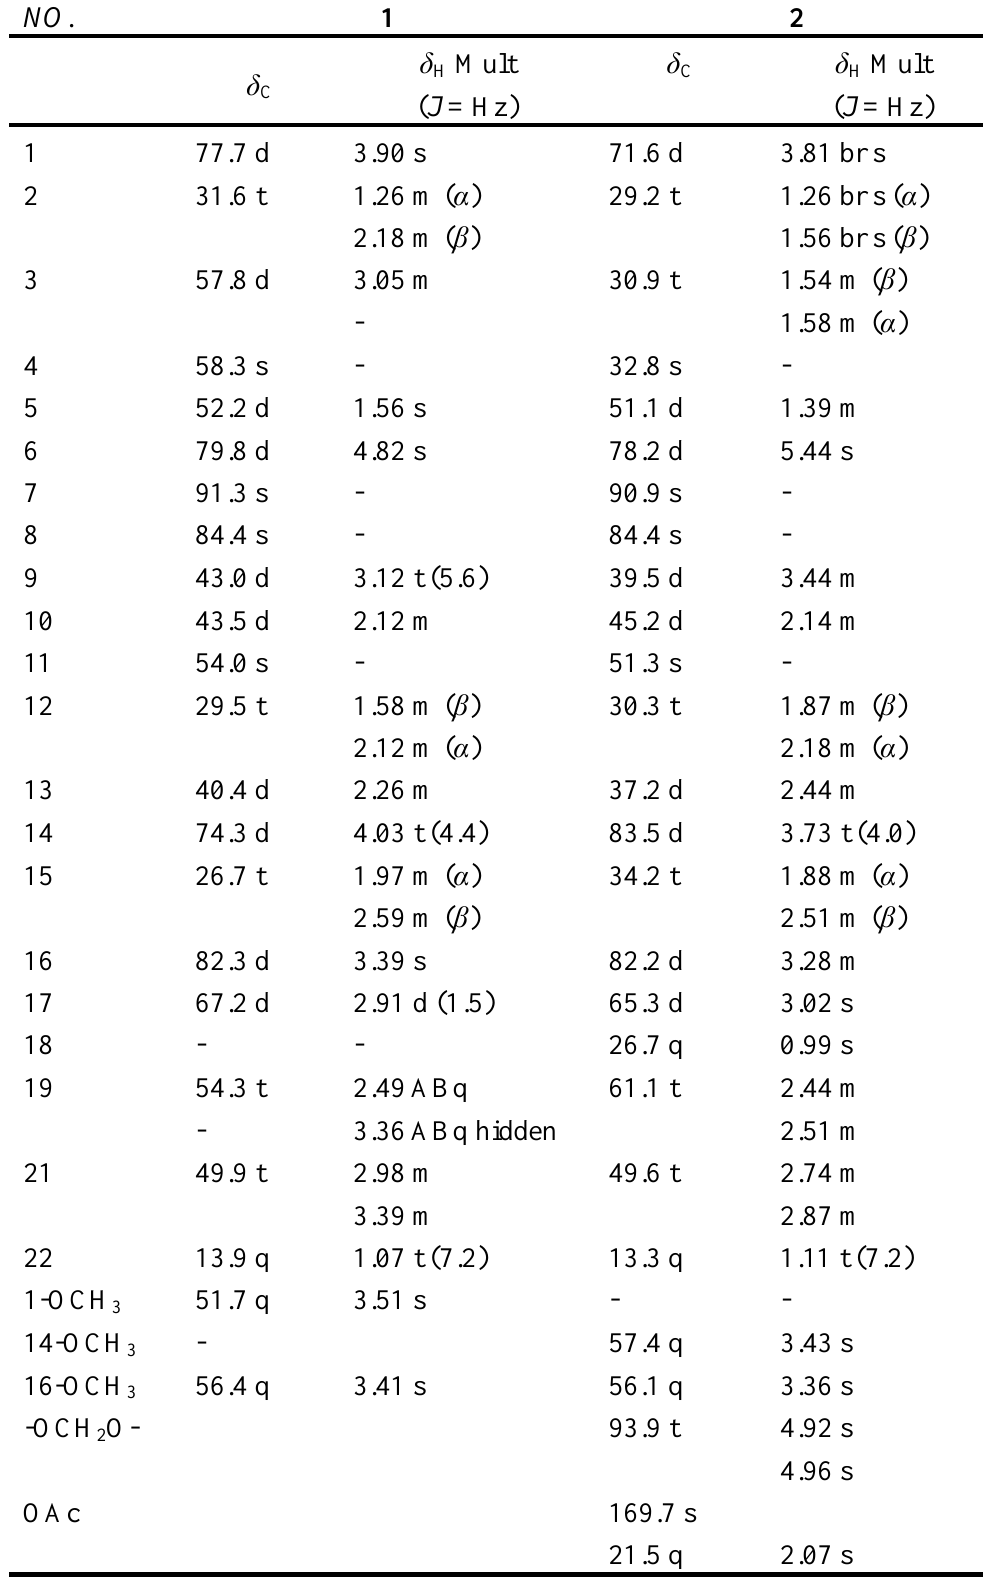
(400 MHz for 1 H, 100 MHz for 13 C). 3